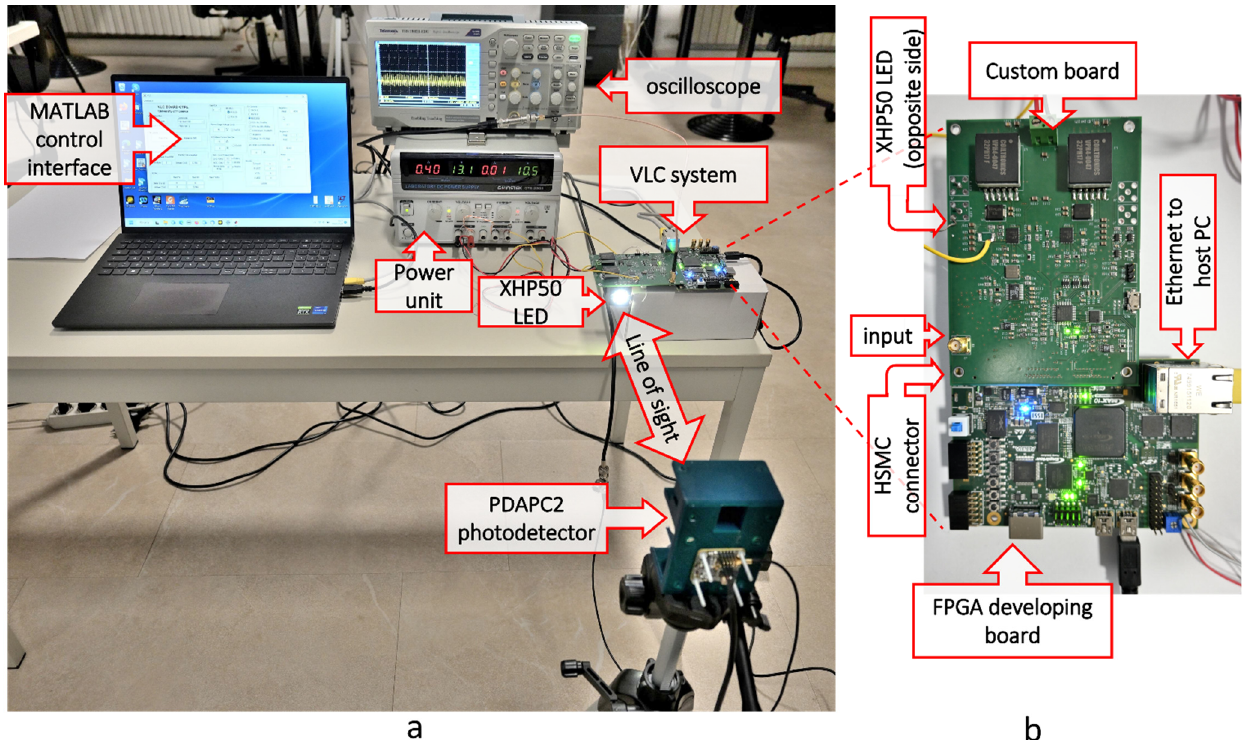
Figure 10. ( a ) Experimental setup composed by the VLC system, the host PC where the MATLAB interface runs, a power unit, an oscilloscope, the XHP50 LED, and the PDAPC2 detector held by a tripod. ( b ) Detail of the VLC system: the VLC custom board and the FPGA board are visible on the top and bottom, respectively. Table 3. Parameters of the experimental